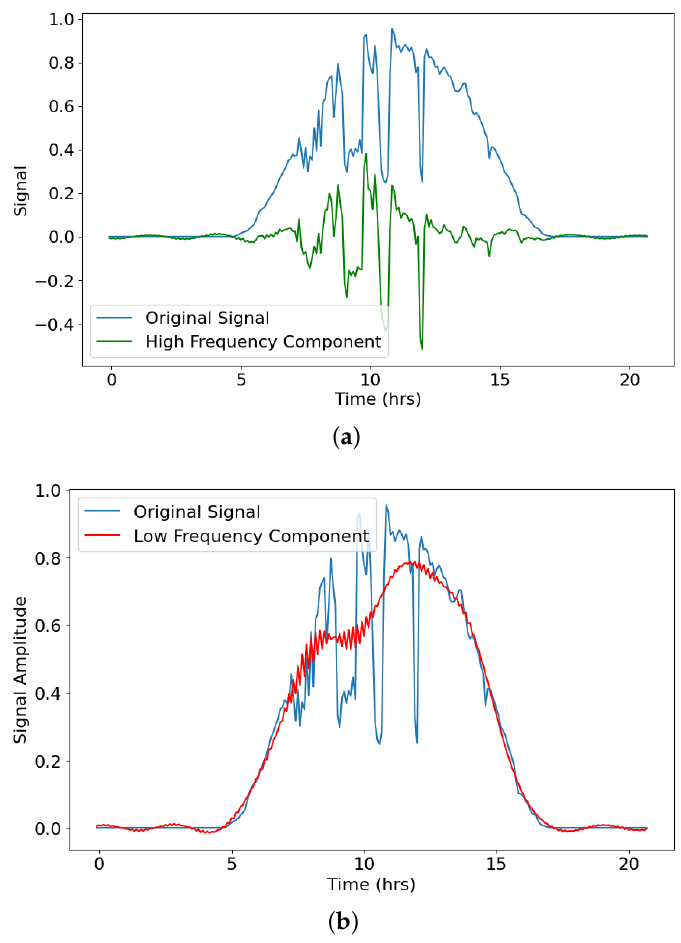
Figure 6. Comparison between the original signal and the signals obtained after data decomposi- tion using FFT filtering: ( a ) High Frequency Component of the original data ( b ) Low Frequency Component of the original